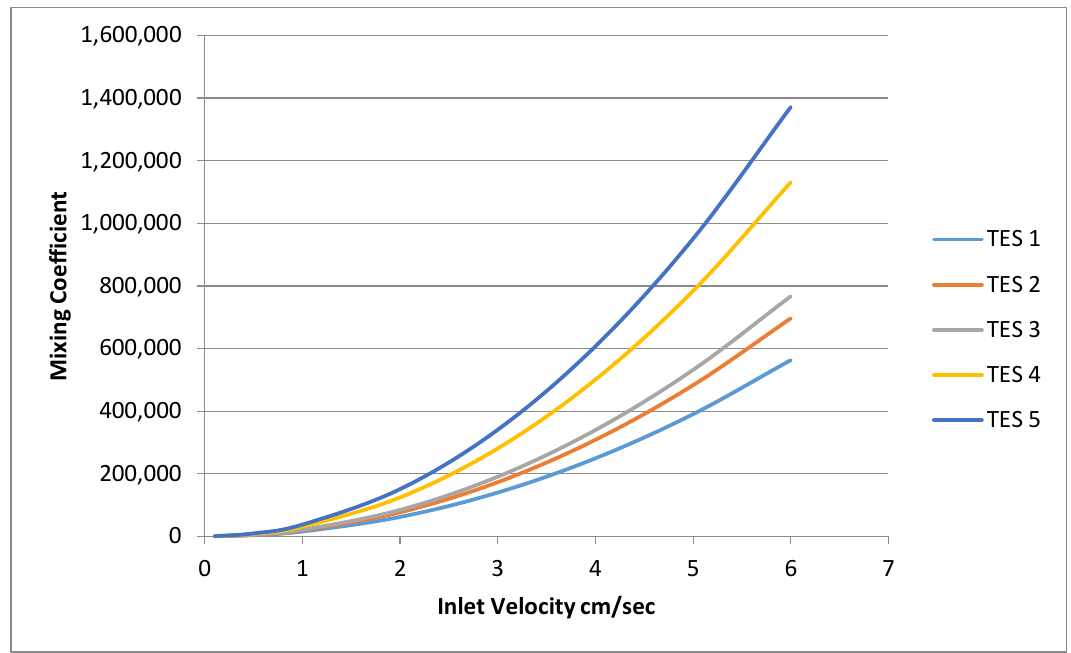
Figure 4. Graph showing the mixing effect for aspect ratios and inlet velocities.